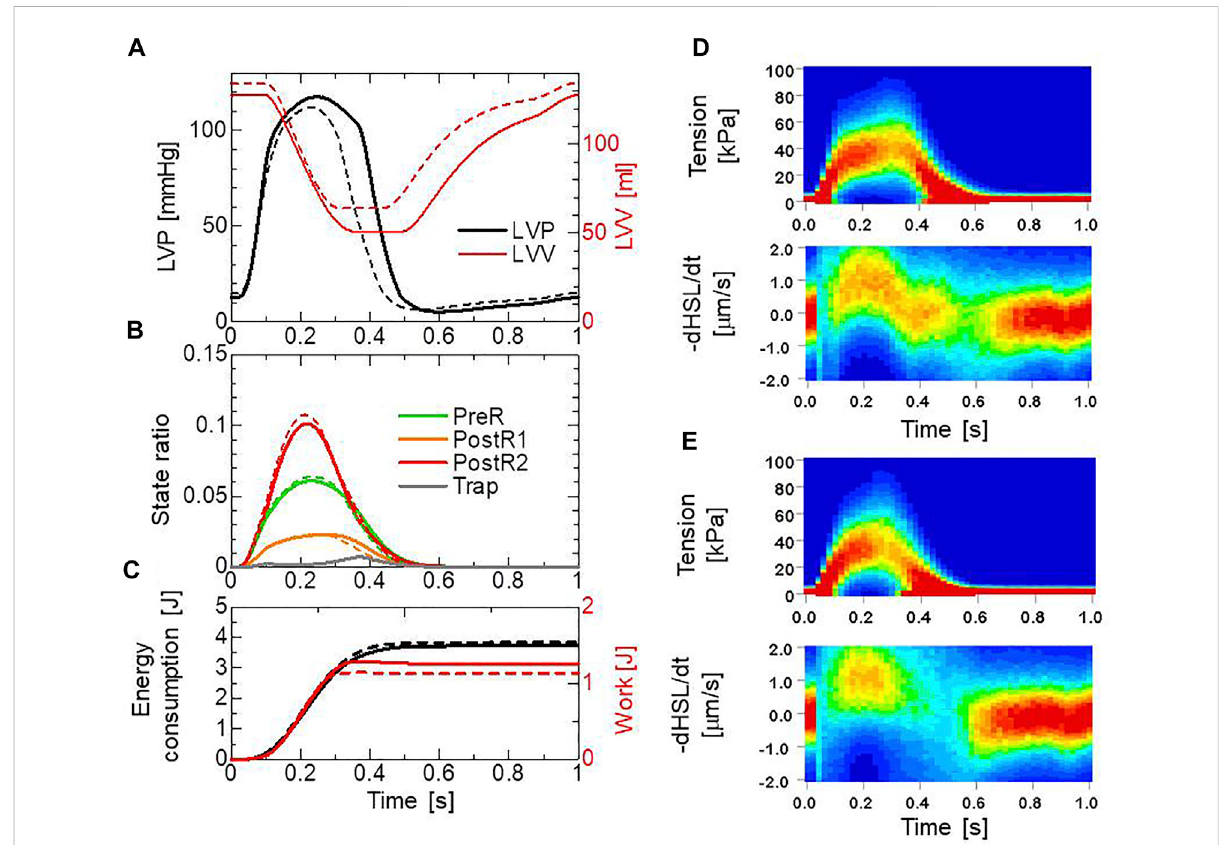
FIGURE 12 Numerical results of the beating ventricle simulation using the bi-ventricular FEM. (A) Time courses of the left ventricular pressure (black) and volume(red)fortheno-trapMHmodel(broken lines)andthetrapmodel(solidlines). (B) TimecoursesofthepopulationratioofattachedMHsinthe leftventricularwallclassi fi edaccordingtotheattachedstates:XB PreR (green),XB PostR1 (orange),XB PostR2 (red),andXB Trap (gray),fortheno-trapmodel (broken lines) and the trap model (solid lines). (C) Time courses of the cumulative ATP energy consumption (black) and work (red) in the left ventricular wall for the no-trap model (broken line) and the trap model (solid line). (D) Contours of the tension distribution (upper) and the half- sarcomere shortening velocity (lower) for the trap MH model. (E) Contours of the tension distribution (upper) and the half-sarcomere shortening velocity (lower) for the no-trap MH